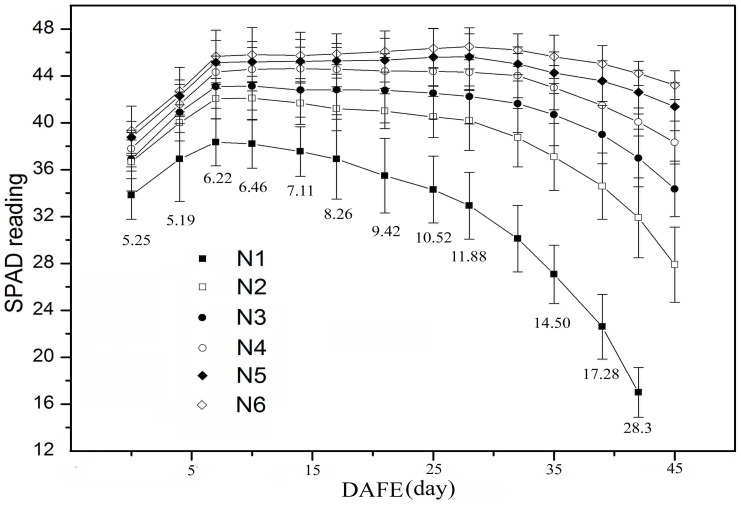
Temporal dynamics of SPAD readings of labeled rice leaves under six N application rates.Each value is an average of 30 measurements. Bars indicate standard error of means. Numbers underneath bars are coefficients of variation (%) of SPAD readings obtained on the same day under the six N application rates. SPAD readings are not shown for control plants on the 45th day after full expansion (DAFE 45) because some leaves in plots without N application were dead. N1 to N6 are the same as in the legend in Fig. 1.